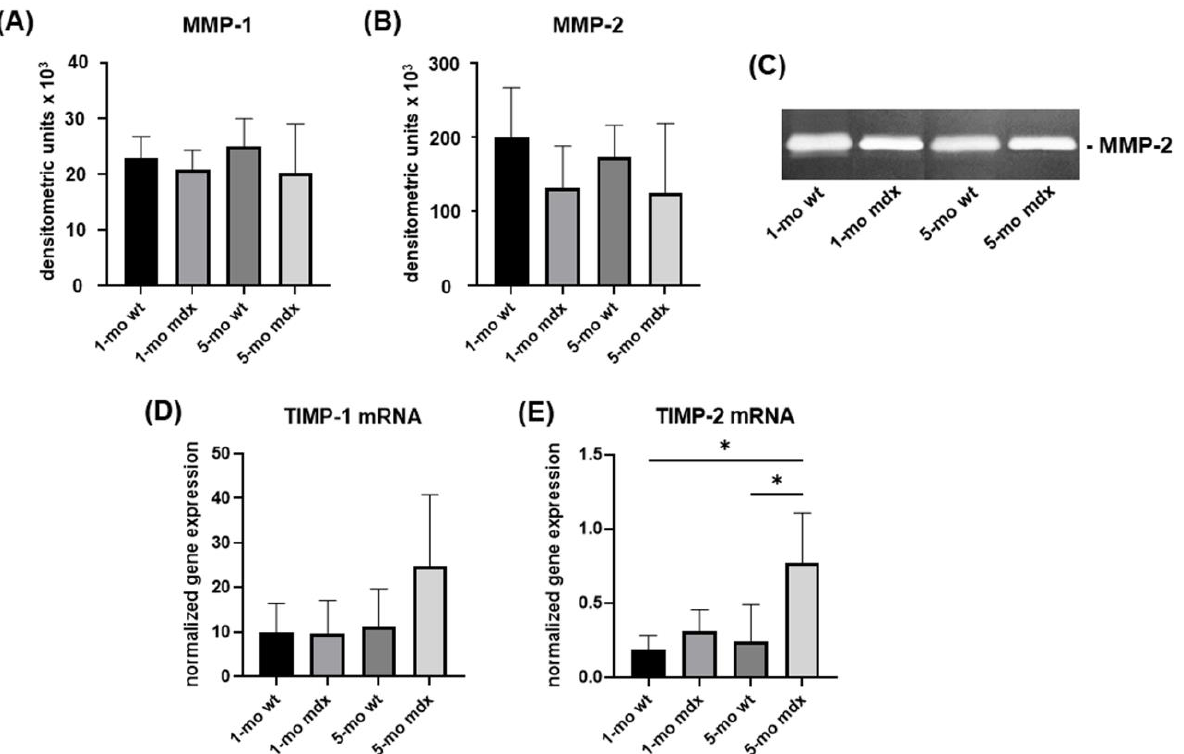
Figure 9. Representative bar graphs showing MMP-1 ( A ) and MMP-2 ( B ) levels in cell culture supernatants of cultured QD muscle fibroblasts analysed by Slot Blot and SDS-zymography, respectively. A representative zymogram is shown in panel ( C ). Gene expression for TIMP-1 ( D ) and TIMP-2 ( E ) were quantified by real-time PCR. Data are mean ± SD. * p < 0.05.